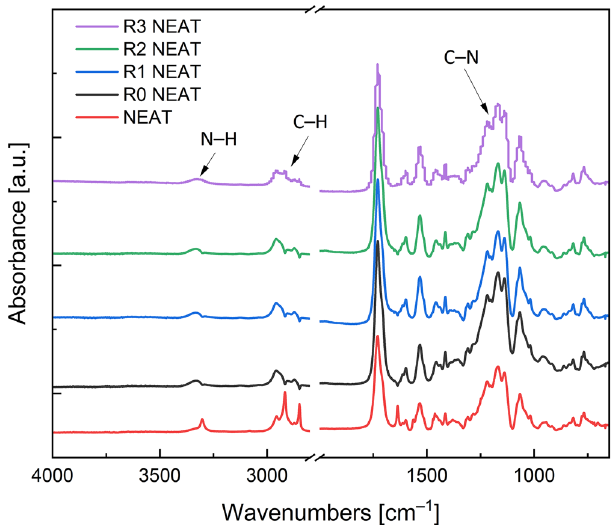
Figure 1. FTIR analysis of neat TPU matrix for each reprocessing cycle.